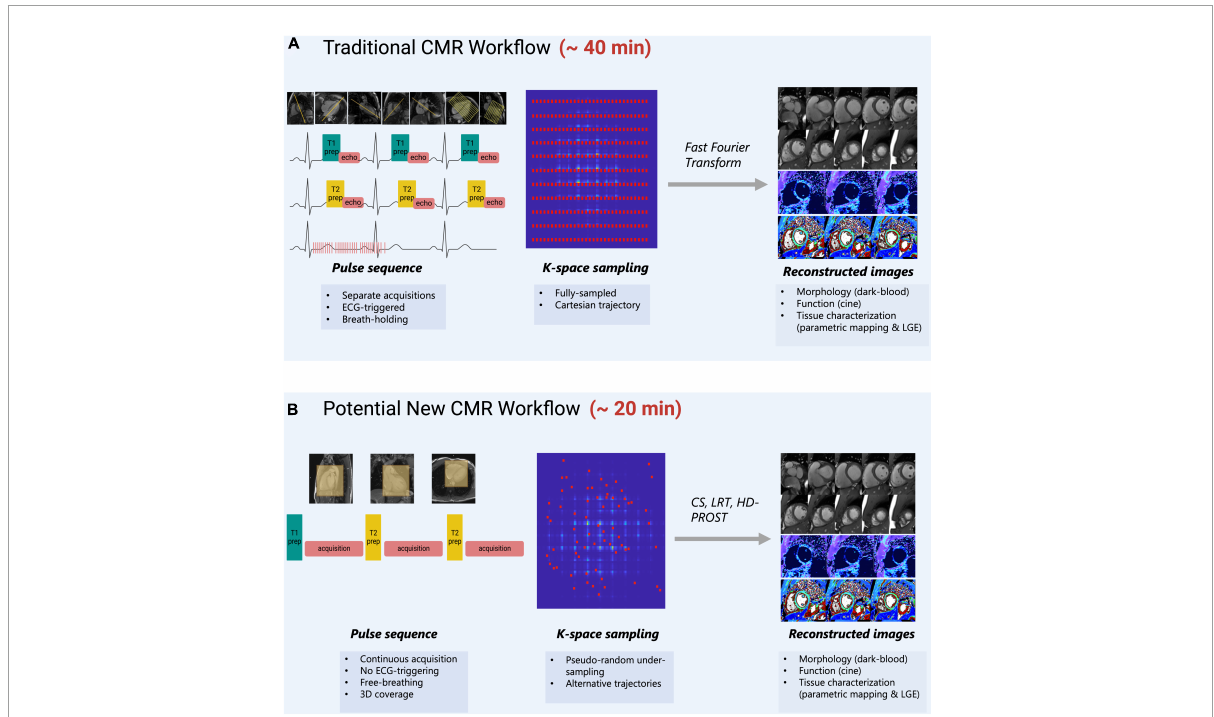
FIGURE1 (A) Traditional CMR scanning workflow which requires separate image acquisitions to acquire images of different contrasts. Images are planned sequentially which requires time and specialized training to understand cardiac anatomy. ECG-triggers and breath-holding are needed to obtain images when motion is minimal. K-space is normally fully sampled and a fast-Fourier transform is used to obtain images with high image quality. (B) A potential new CMR workflow that is suggested by SMART-CMR. The novelty behind these SMART is to simplify CMR scanning by taking advantage of the redundancies which exist between images of different contrasts. Some SMART allow for imaging acquisitions without ECG-gating or breath-holding with whole-heart coverage. The acquisition planning is simplified, often simply requiring the placement of a volumetric box over the heart. For these methods to reduce scan time, pseudo-random under-sampling is often used in combination with alternative reconstruction approaches such as compressed-sensing (CS), low-rank tensor (LRT) methods, or high-dimensionality undersampled Patch based Reconstruction